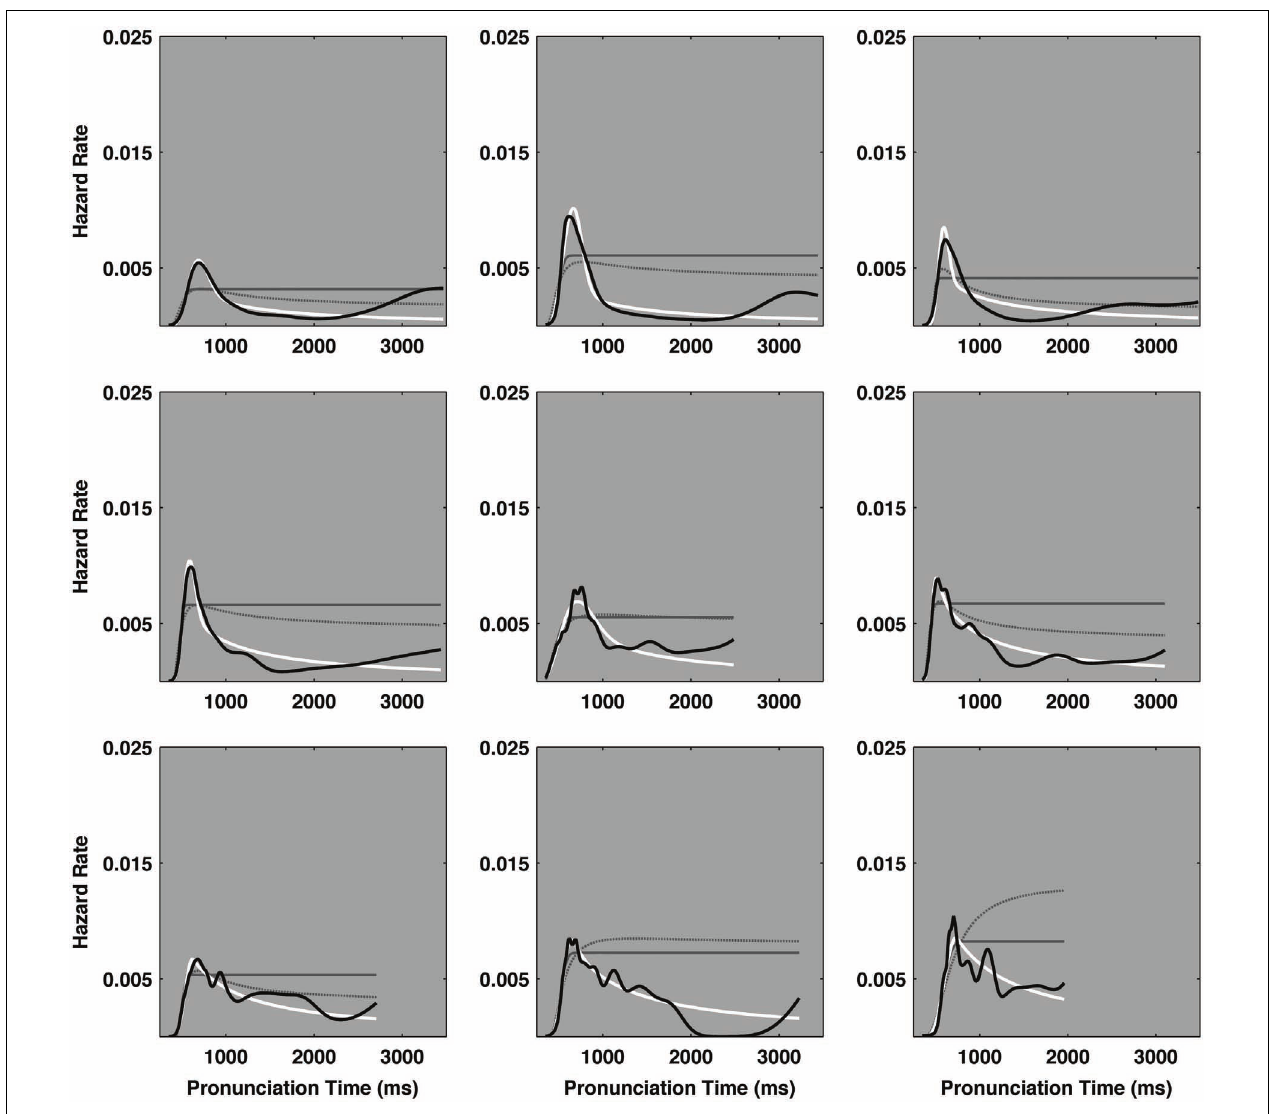
ex-Gaussian and ex-Wald hazard functions were nearly identical.The majority of the hazard functions entail a peak and their slow tails more closely match the power law decay indicated in the cocktail description than the exponential decay indicated by either the ex-Gaussian or ex-Wald models.The plots are depicted according to the ascending rank order of the scaling exponent derived from the cocktail fits.The distribution in the top left plot yielded the smallest power law scaling exponent ( α = 3.04), the bottom right plot yielded the largest scaling exponent ( α = 7.33). α = power law scaling